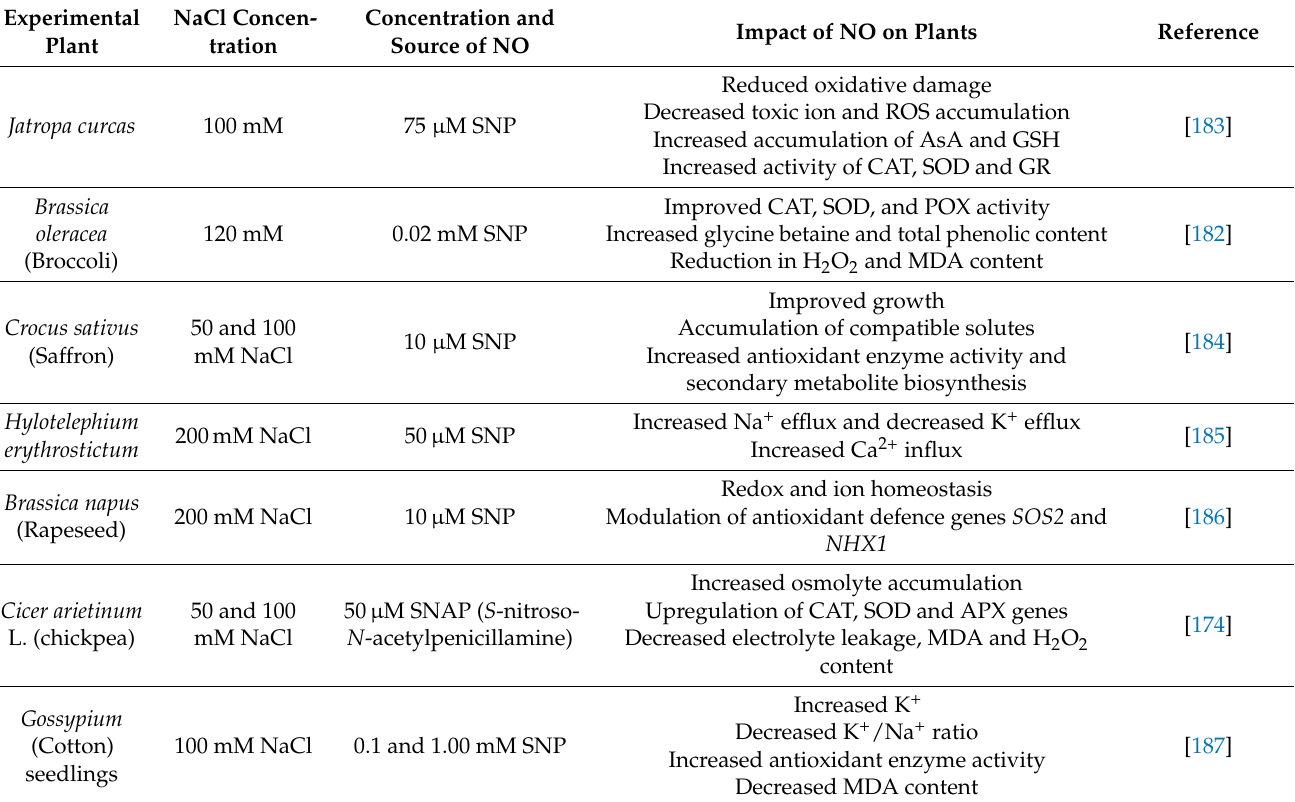
Table 3. Compilation of recent studies on the role of NO in ameliorating plant responses to salinity